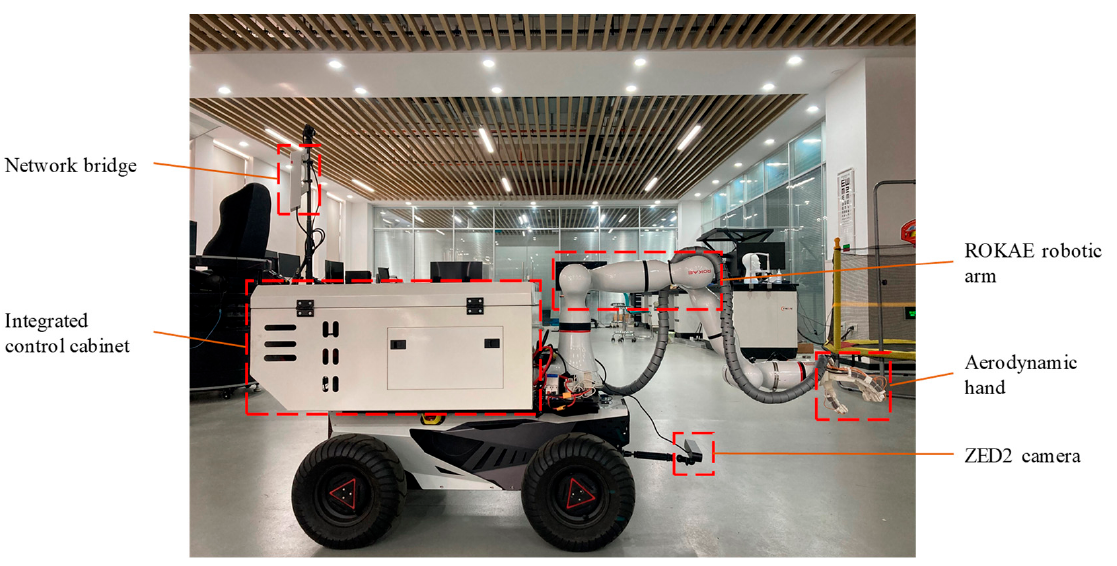
Figure 8. The teleoperated robot experiment platform for distance estimation.